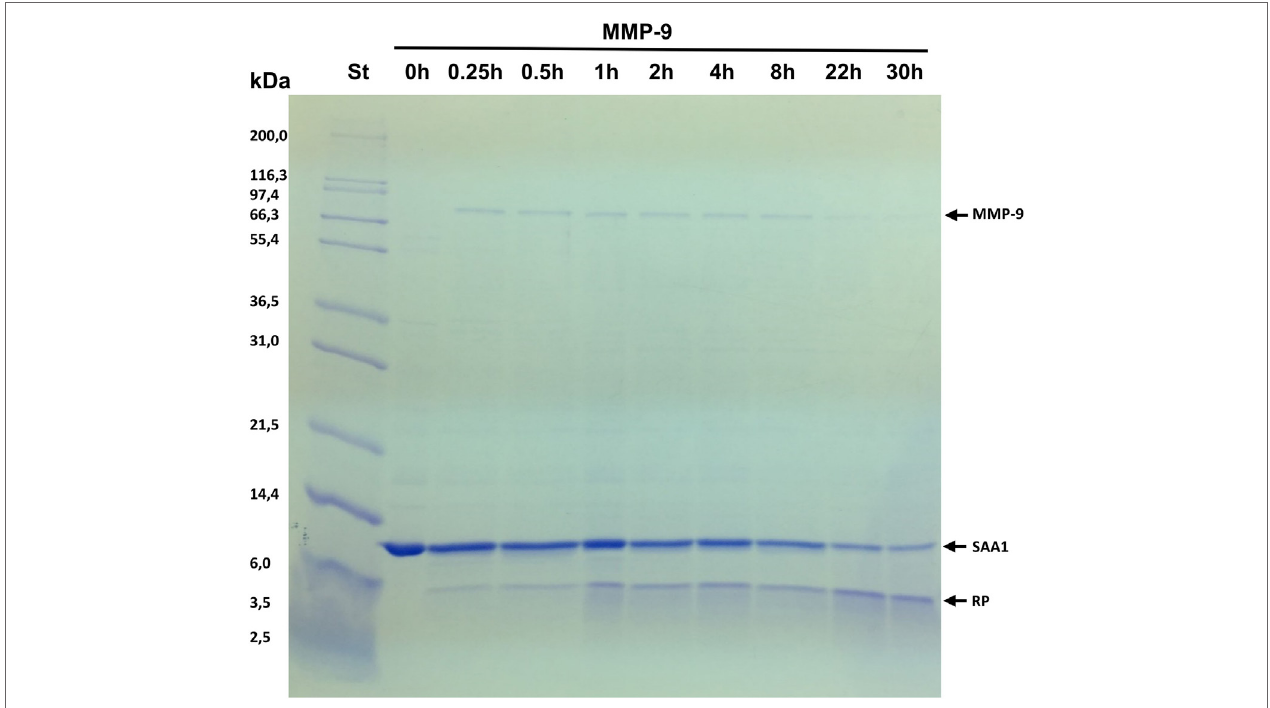
FigUre 1 | Cleavage of serum amyloid A1 (SAA1) by matrix metalloproteinase-9 (MMP-9). Pro-MMP-9 was activated with the catalytic domain of MMP-3, and recombinant human SAA1 was incubated at 37°C with activated gelatinase B/MMP-9 at an enzyme:substrate molar ratio of 1:50. Samples taken at the indicated time points were analyzed by SDS–PAGE and Coomassie brilliant blue protein staining. The relative molecular weight of the standard marker proteins (St) is indicated in kilodaltons. After incubation for prolonged time intervals (22 and 30 h), some autocatalysis of MMP-9 was detected, slowing down the conversion of SAA1 into reaction products